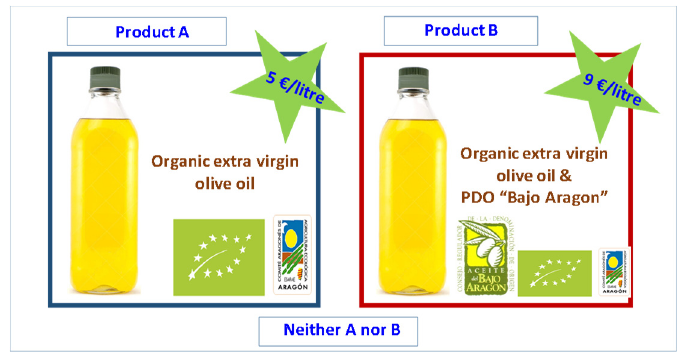
Figure 1. Choice set example of the unlabeled experiment *. * Original figures were presented in Spanish, Source: own elaboration.